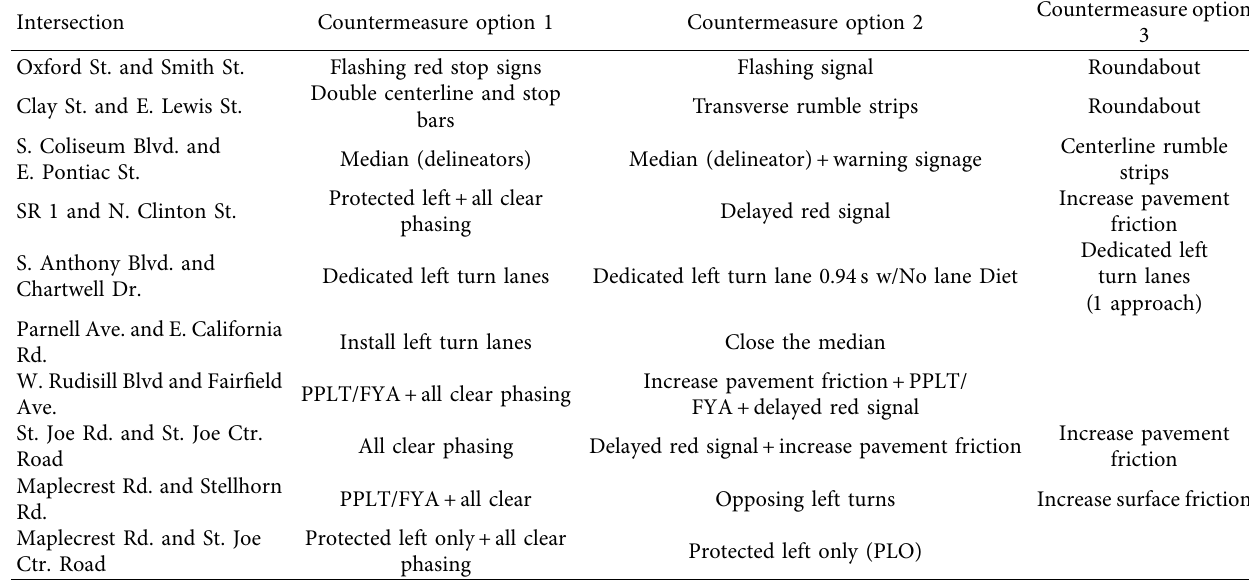
Table 5: Alternate safety countermeasures at a